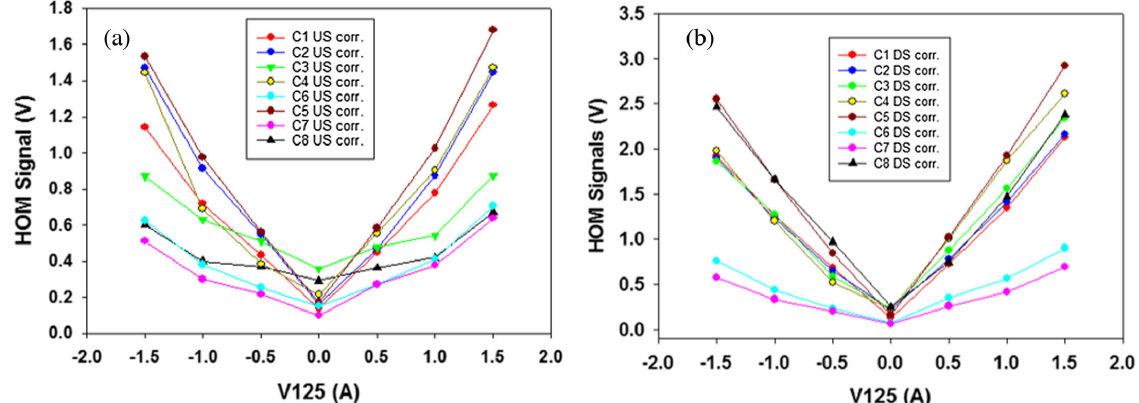
FIG. 9. Measurements of the CM2 (a) US and (b) DS HOM peak signals from the Schottky data. We have identified a reference corrector current setting for our 0.0 A with an actual V125 current value of 4.3 A after scanning for a relative minimum in CM2 US HOM channels. The H125 value was fixed at a reference.